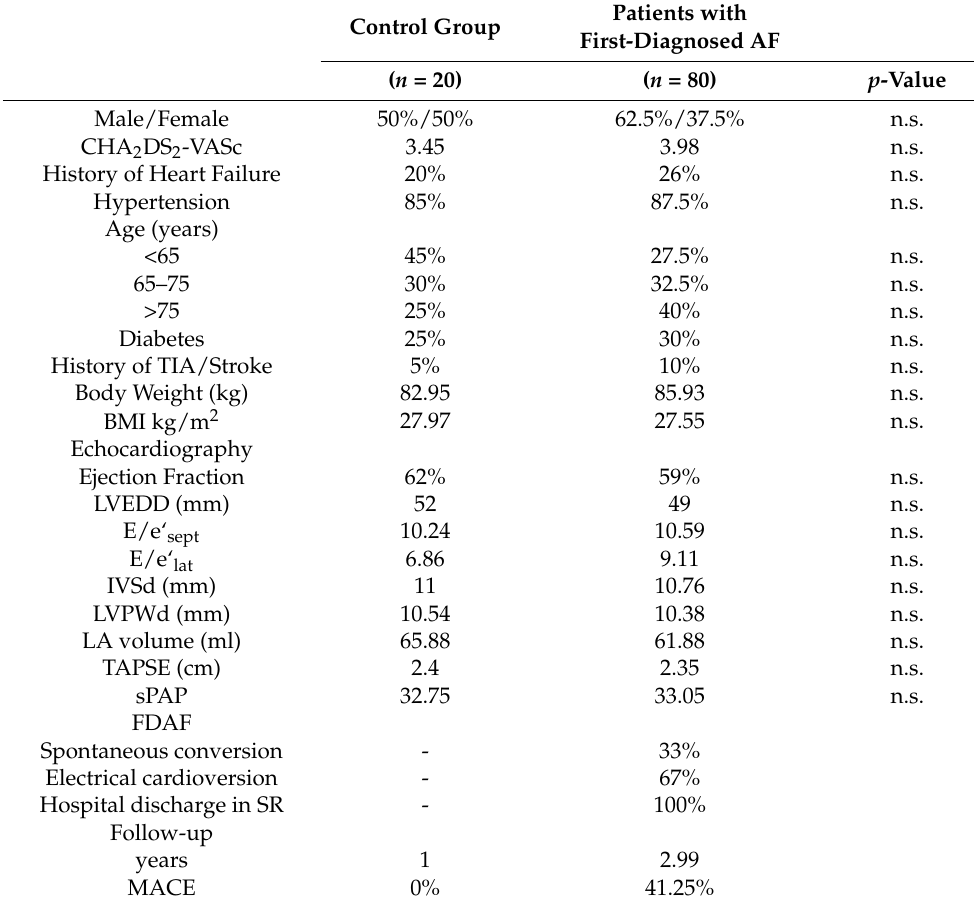
Table 1. Baseline characteristics of patients with first-diagnosed AF and controls. Patients Control Group